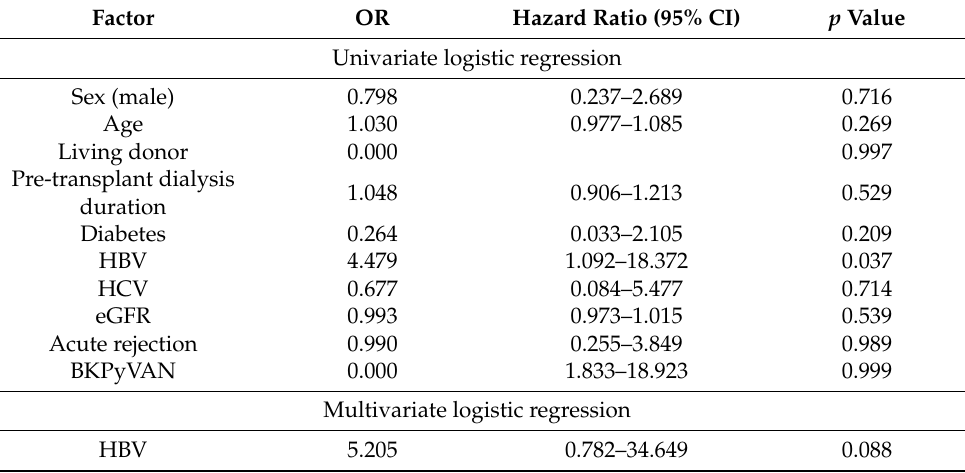
Table 4. Univariate and multivariate logistic regression analysis to identify relative risks of urinary tract cancers in kidney transplant